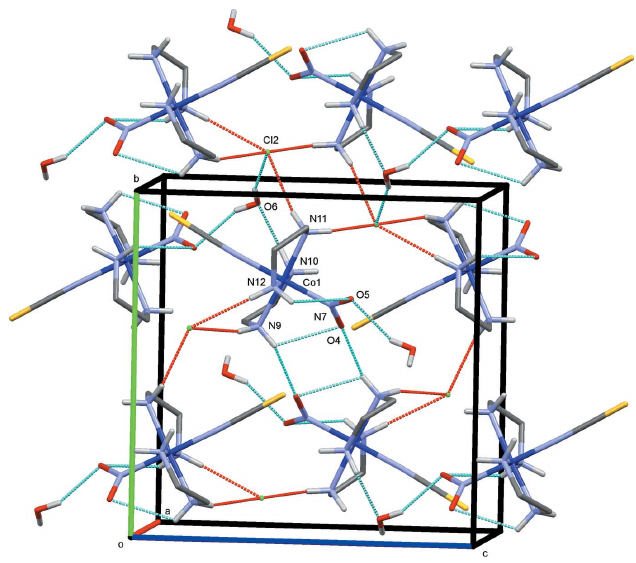
Figure 5 The crystal structure of (II), projected along a . Hydrogen bonds are shown as dashed lines in blue for O—H (cid:2)(cid:2)(cid:2) O/Cl and N—H (cid:2)(cid:2)(cid:2) O, and in red for N—H (cid:2)(cid:2)(cid:2) Cl.